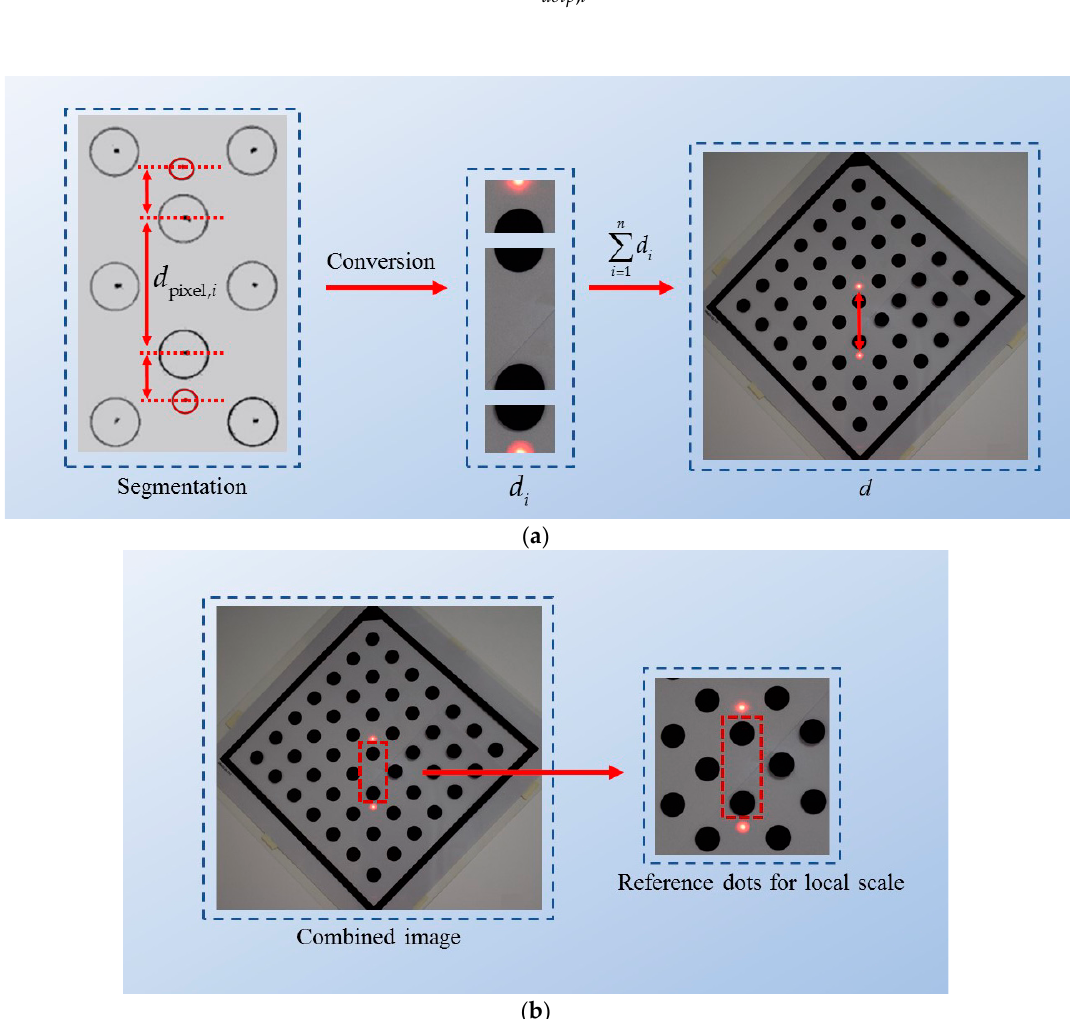
Figure 6. The process of conversion: Segmentation method. ( a ) The process of conversion; ( b ) the selection of the reference dots for the local scale.